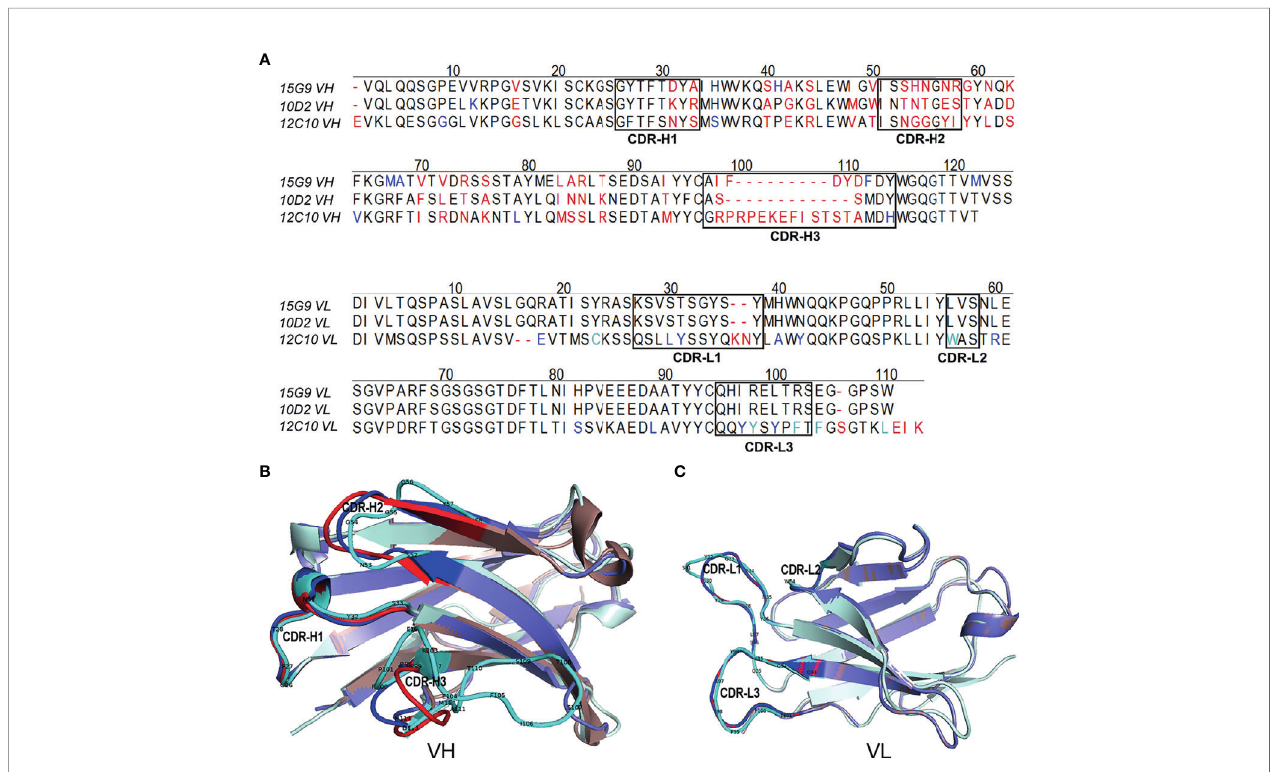
FIGURE 4 | Sequence characteristics of the mAbs. (A) Multiple alignment of the variable regions of 15G9, 12C10 and 10D2. The black boxes indicated the complementarity-determining regions (CDRs). (B) Structural alignment of VHs for 15G9, 12C10 and 10D2. (C) Structural alignment of VLs for 15G9, 12C10 and 10D2. 15G9 (darksalmon), 12C10 (palecyan), 10D2 (slate). The CDRs of 15G9, 12C10, 10D2 were marked as red, cyan and blue, respectively. The variable region sequences of these mAbs had been submitted to GenBank and the accession numbers were MZ751046, MZ751047, MZ751048, MZ751049 and MZ751050,